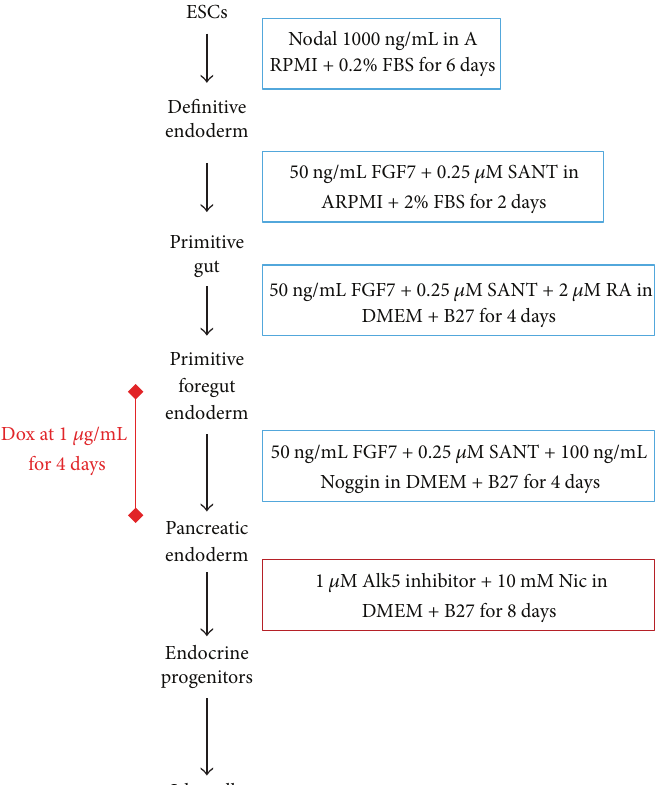
Figure 5: Pancreatic differentiation protocol adapted from Sneddon et al. [25]. Cells were seeded at a density of 60,000 cells/cm 2 either on Gelatin or on Matrigel. PTF1a was induced by adding 1 𝜇 g/mL Dox for 4 days overlapping with the end of primitive foregut endoderm stage (PF) and pancreatic endoderm stage (PE). Following the PE stage, cultures were further treated with Alk5 inhibitor and Nicotinamide (a maturation factor) for 8 days and analyzed for markers specific to adult pancreatic cell